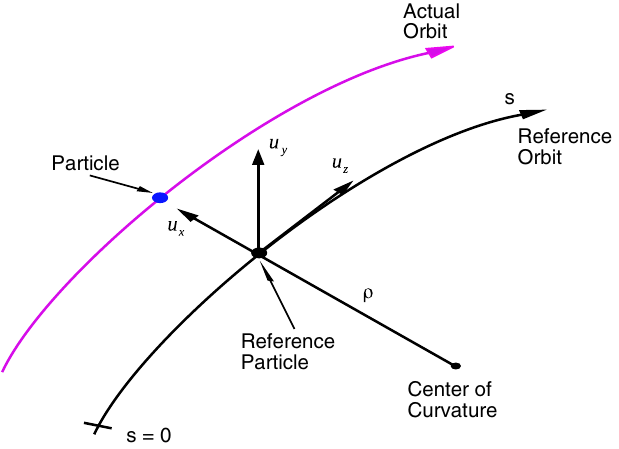
FIG. 1. The local reference coordinate system used for ana- lytical derivations and for comparative tracking studies using BMAD [27]. The reference orbit lies in the (theoretical) median plane of the accelerator: u is the unit vector pointing along z the momentum direction of the reference particle, u radially outwards and u is the vertical unit vector defined y u as u × u y ¼ z x